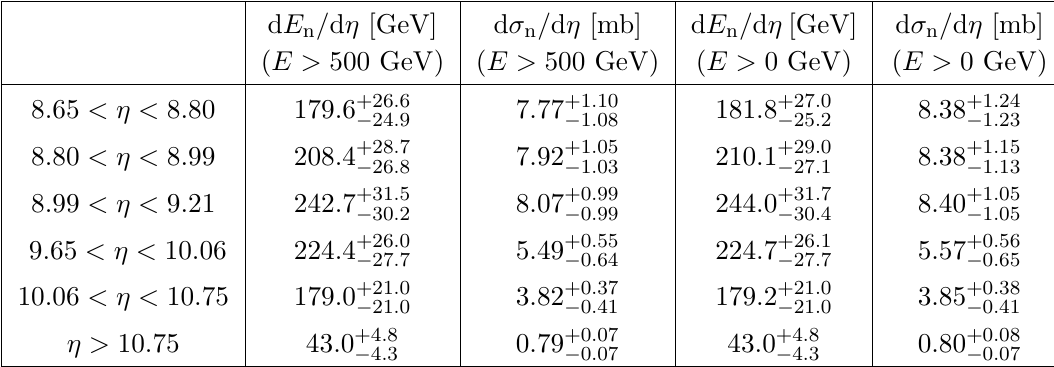
Table 4 . Di(cid:11)erential energy (cid:13)ow d E n = d (cid:17) and di(cid:11)erential cross section d (cid:27) n = d (cid:17) of neutrons produced p in p-p collisions at s = 13 TeV, measured using the LHCf Arm2 detector. Upper and lower uncertainties are also reported. The values are relative to the experimental measurements with ( E > 0 GeV) and without ( E > 500 GeV) the simulation-driven correction factors for the limited detection e(cid:14)ciency below 500 GeV. The last two columns correspond to the numbers used for the experimental points shown in (cid:12)gure